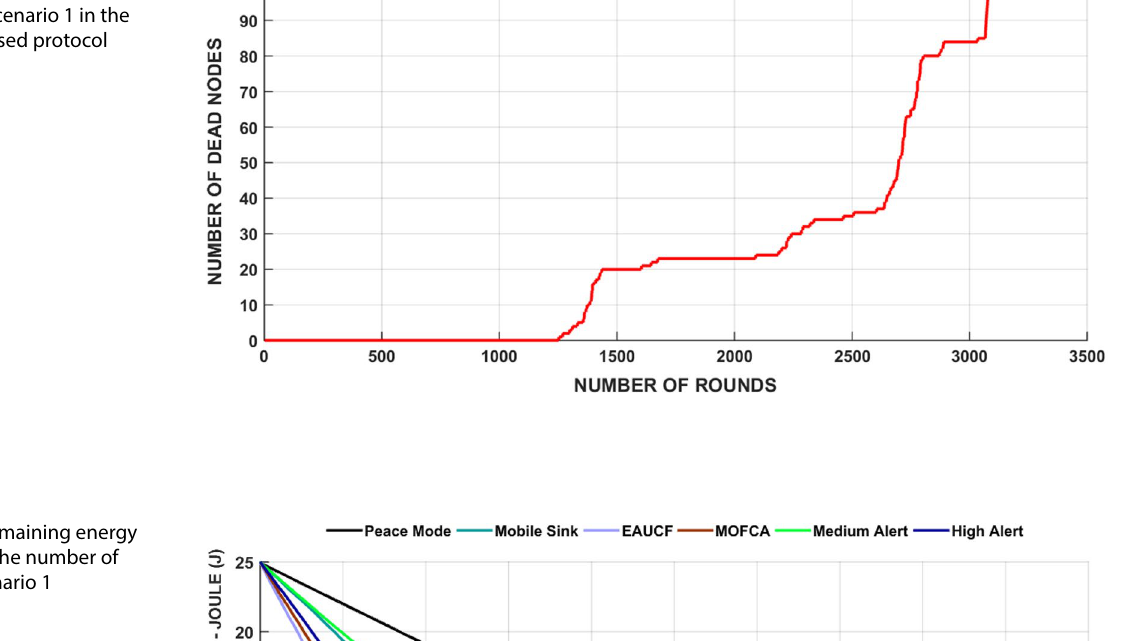
Fig. 6 Ratio of the number of dead nodes to the number of rounds in scenario 1 in the second proposed protocol